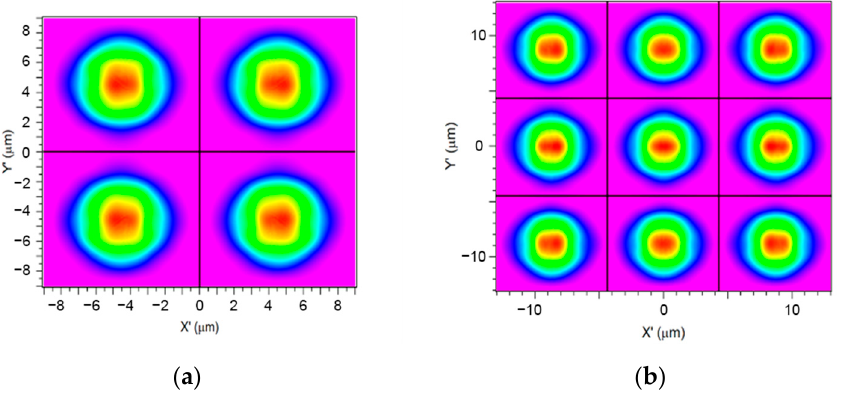
Figure 5. Output modal field distribution at the end of the MMI splitters: ( a ) 1 × 4 MMI; ( b ) 1 × 9 MMI.